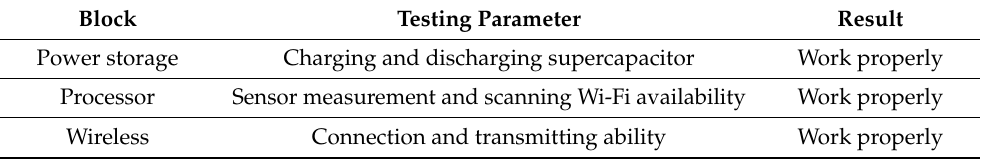
Table 9. Functionality testing results.